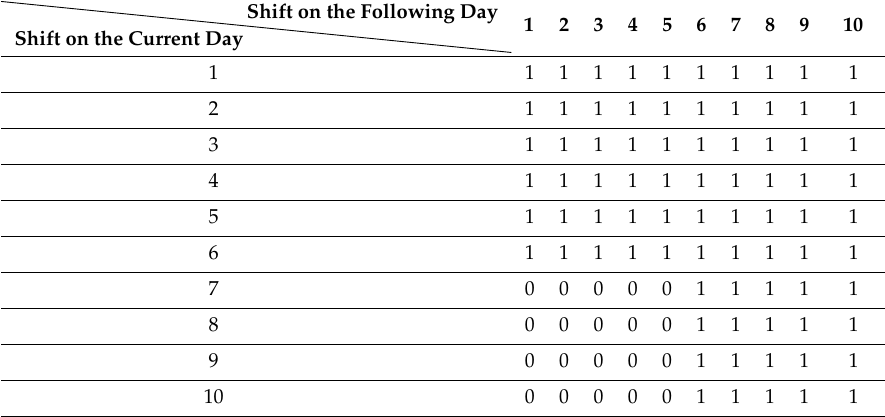
Table 6. Relationships between consecutive